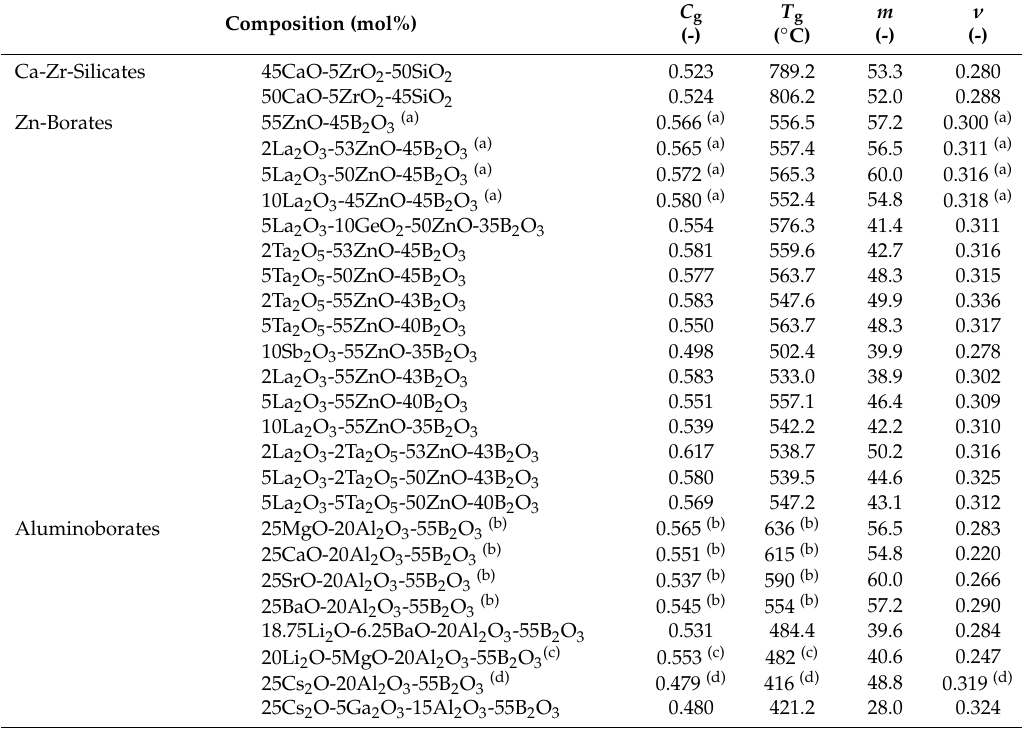
Table 1. Atomic packing factor ( C g ), glass transition temperature ( T g ), liquid fragility ( m ), and Poisson’s ratio ( ν ) of various oxide glasses, either synthesized for this work or taken from previous studies [18,46–49,52]. The errors in C g , T g , m , and ν are estimated to be within ± 0.002, 2 ◦ C, 1, and 0.01,